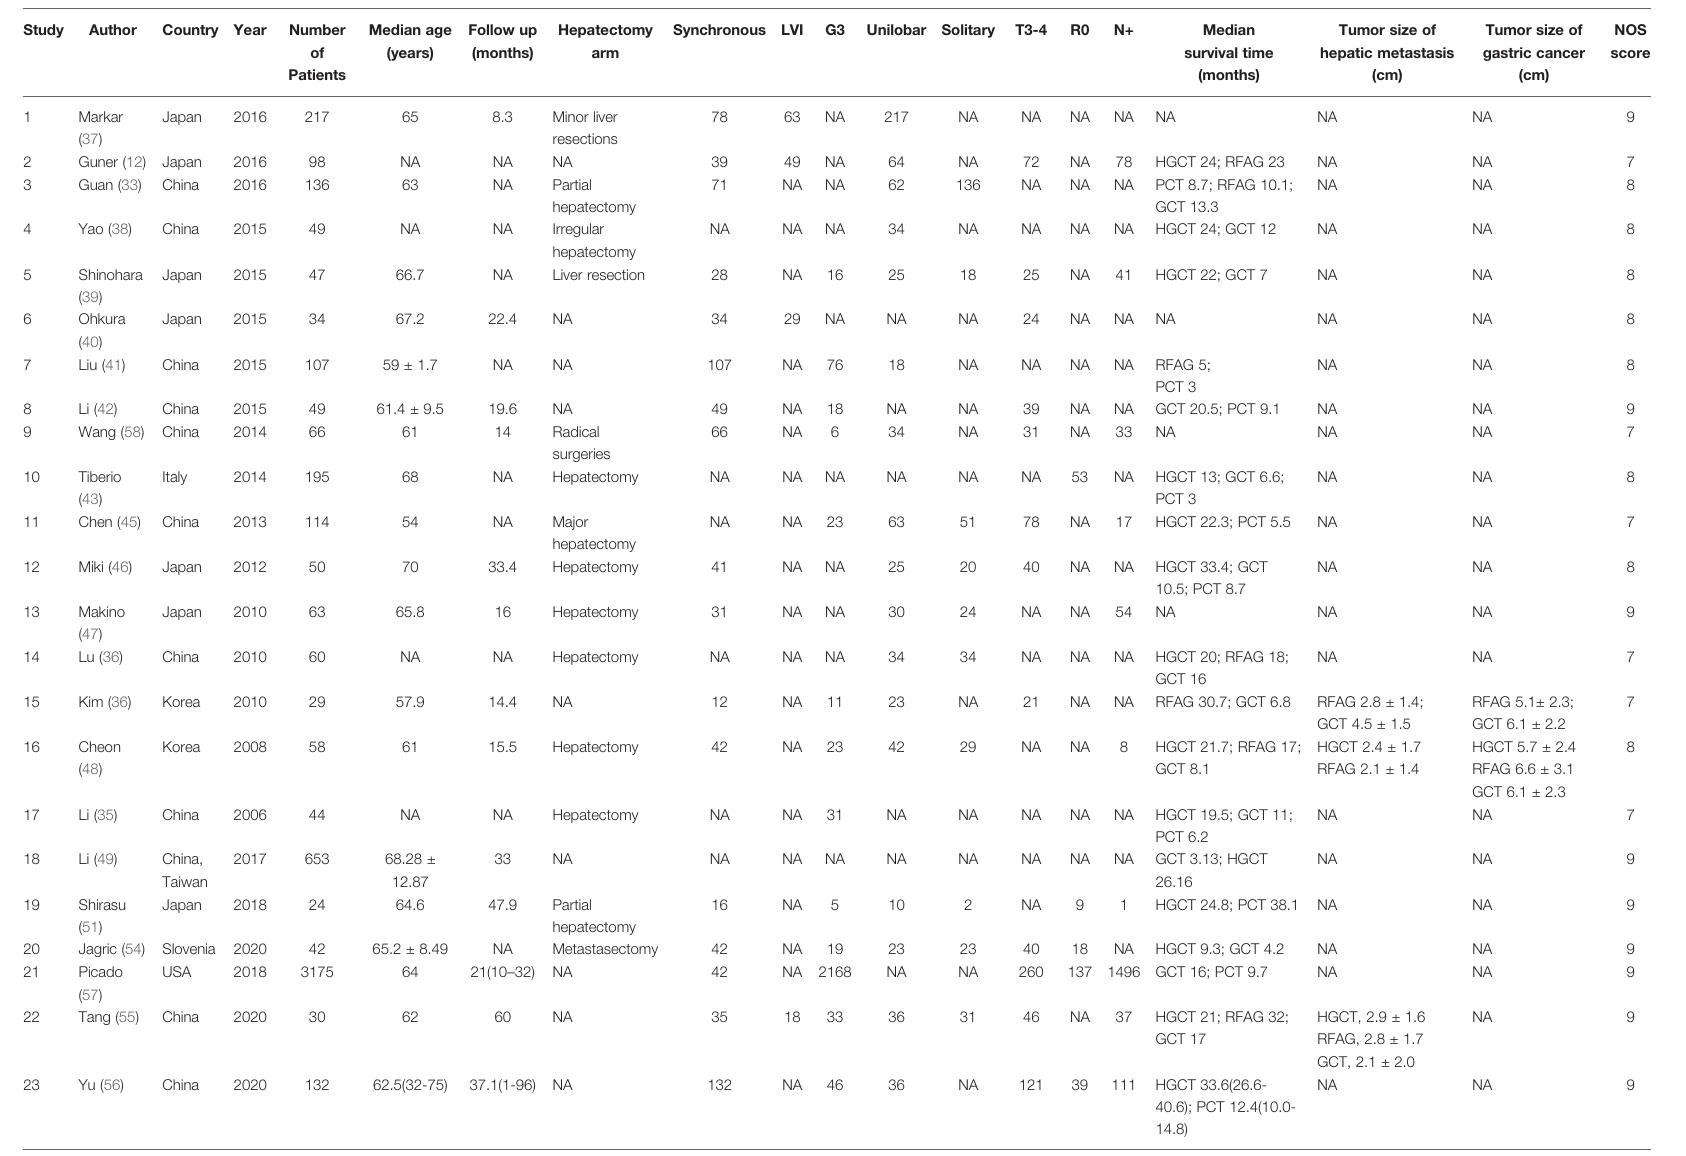
NA, Not available; Synchronous, Number of patients with synchronous liver metastases; N+, Number of patients with lymph-node involvement of the primary cancer; T3-4, Number of patients with stage pT3 or pT4; LVI, Number of patients with lymphovascular involvement; G3, Number of patients with G3 primary cancer; Unilobar, Number of patients with unilobar liver involvement; R0, Number of patients who achieved an R0 surgical removal on both primary cancer and liver metastases; Solitary, Number of patients with solitary liver metastases; HGCT, hepatectomy and gastrectomy plus chemotherapy; GCT, gastrectomy plus chemotherapy; PCT, palliative chemotherapy; RFAG, radiofrequency ablation and gastrectomy plus chemotherapy; TACEG, transarterial chemoembolization and gastrectomy plus